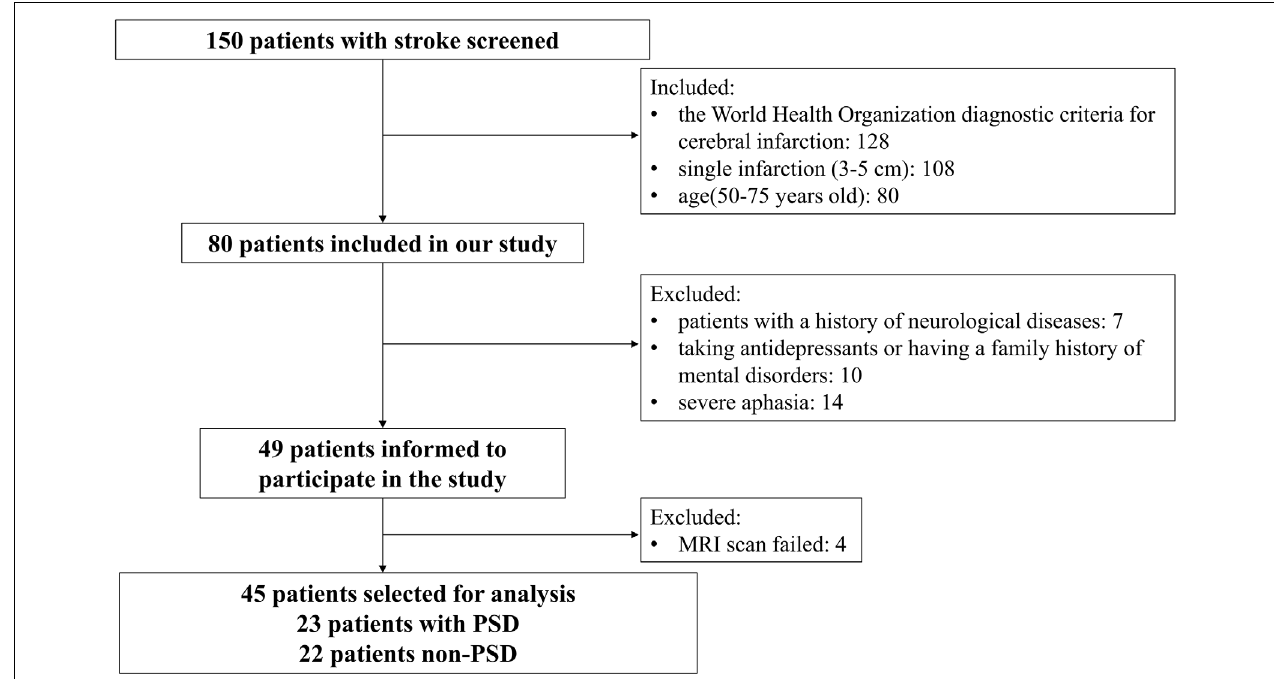
FIGURE 1 | Flowchart of patient